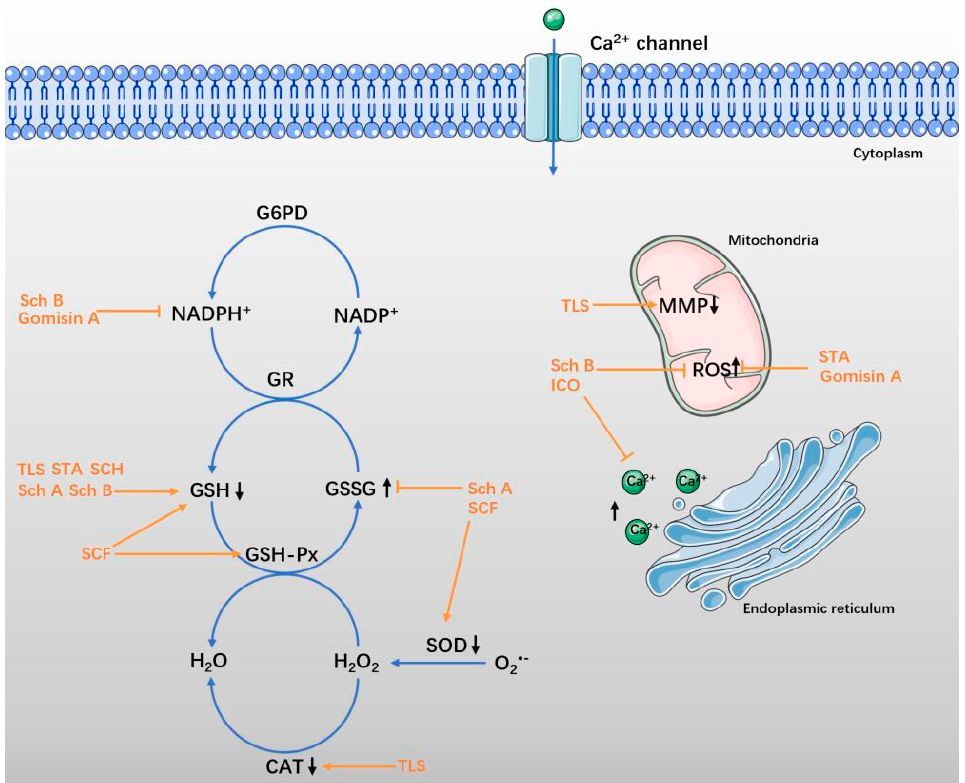
Figure 2. SCF and its active ingredients protect against oxidative stress in neurological diseases (NDs). Under pathological conditions, the redox balance is disrupted. The degradation of glutathione (GSH) is accelerated when the GSH-Px activity is decreased, and the production of glutathione disulfide (GSSG) is increased [64–66]. The expression of enzymes with antioxidant effects, as superoxide dismutase (SOD) and catalase (CAT), are inhibited simultaneously [67–69]. The mitochondrial membrane potential (MMP) decreases, while reactive oxygen species (ROS) is released excessively [70,71]. Intracellular Ca 2+ influx, as well as intracellular Ca 2+ release from the endoplasmic reticulum are increased, resulting in a series of downstream pathological responses [72–74]. The protective effect of SCF and its active ingredients are shown in orange.